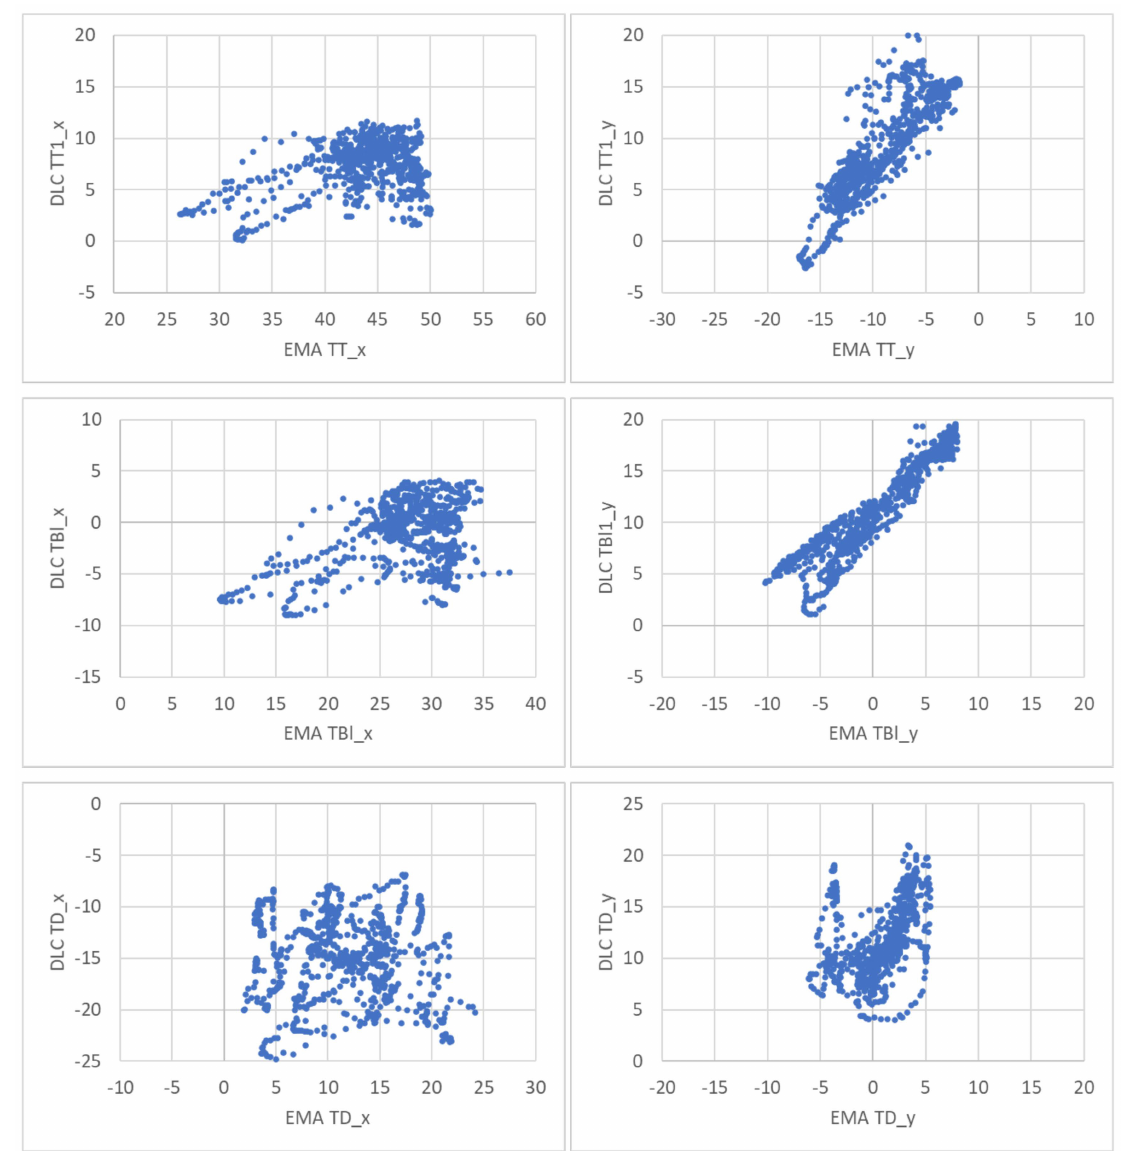
Figure 15. EMA coordinate vs. DLC estimated coordinate plotted for every ultrasonic frame of the 5 si- multaneous EMA/ultrasound recordings. TT—tongue tip; TBl—tongue blade; TD—tongue dorsum.